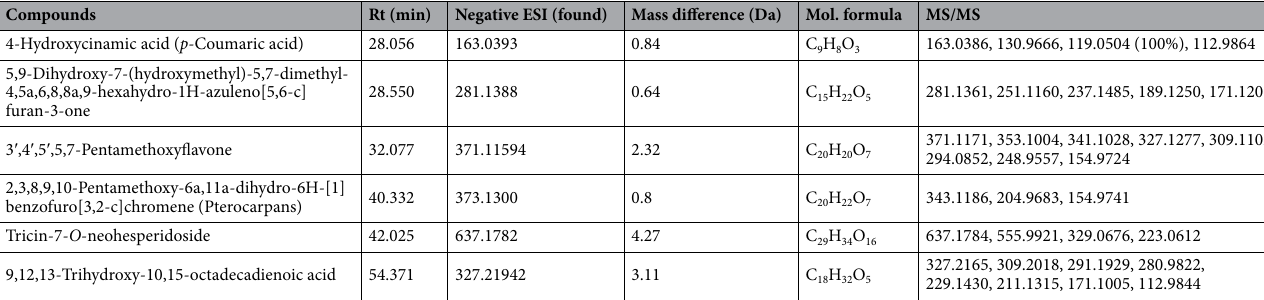
Table 9. LC-TOF–MS analysis of the butanol fraction of S. officinarum leaves and tentative identification of compounds.